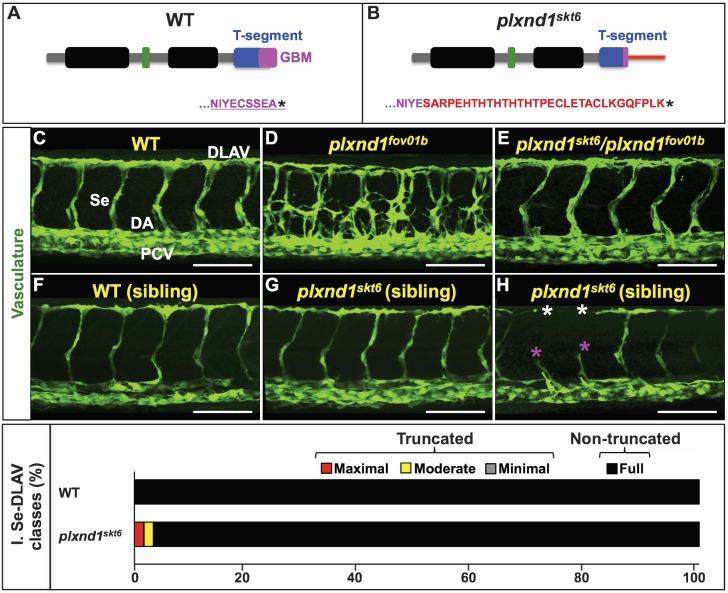
The plxnd1skt6 allele encodes a functional Plxnd1 receptor putatively impaired in GIPC binding, and its homozygosity induces angiogenesis deficits with low frequency.(A, B) Diagrams of the cytosolic tails of the zebrafish Plxnd1 proteins encoded by the WT (A) and plxnd1skt6 mutant (B) alleles including their C-terminal amino acid sequences. Color-coding is used to highlight the following domains and motifs. GAP1 and GAP2 (Guanosine triphosphatase-Activating Protein domains 1 (left) and 2 (right); black), RBD (Rho GTPase-Binding Domain; green), T-segment (C-terminal segment, includes the GBM; blue), and GBM (GIPC-Binding Motif; magenta). In the WT protein diagram (A), the canonical PBM (PDZ-Binding Motif) is underlined. In the mutant protein diagram (B), the thin horizontal red bar denotes the amino acid sequence replacing the PBM. (C–H) Confocal lateral images of the trunk vasculature (green) of 32 hpf embryos (region dorsal to the yolk extension). Anterior, left; dorsal, up. Scale bars (white horizontal lines), 100 μm. Genotypes indicated on top of each image in yellow font. Angiogenesis deficits are indicated with asterisks as follows: white (DLAV gaps), magenta (truncated Se). In the WT image (C), the vessels are designated with the white font as follows: DLAV (Dorsal Longitudinal Anastomotic Vessel), Se (Segmental Vessel), DA (Dorsal Aorta), and PCV (Posterior Cardinal Vein). The homozygous WT and homozygous plxnd1skt6 mutant embryos (F–H) are siblings derived from the incross of plxnd1skt6/+heterozygotes. (I) Bar graph. Percentage of Se-DLAV in 32 hpf embryos of the indicated genotypes belonging to each of the following four phenotypic classes. Truncated: maximal (red; includes missing Se), moderate (yellow), and minimal (gray). Non-truncated: Full (black). There was no statistically significant difference in the distribution of the four phenotypic classes between WT and plxnd1skt6 mutants as assessed by a two-sided Fisher Exact test, p=0.05905. Quantifications. To determine whether plxnd1skt6 complements the plxnd1fov01b null, we analyzed vascular patterning (C–E) and scored Se-DLAV angiogenesis (C, E) in embryos of the following three genotypes: WT (124 Se-DLAV, 11 embryos, an average of 11.27 Se-DLAV/embryo), plxnd1fov01b homozygotes (12 embryos), and plxnd1fov01b/plxnd1fov01b transheterozygotes (162 Se-DLAV, 16 embryos, an average of 10.13 Se-DLAV/embryo). All the WT and transheterozygotes displayed proper vascular patterns indistinguishable from each other and lacked Se-DLAV truncations. All the plxnd1fov01b mutants displayed hyperangiogenic vascular mispatterning. To determine how Plxnd1’s inability to interact with GIPCs impacts angiogenic growth, we scored Se-DLAV angiogenesis (F–I) in sibling embryos of the following two genotypes: Homozygous WT (126 Se-DLAV, 12 embryos, an average of 10.5 Se-DLAV/embryo) and plxnd1skt6 homozygous mutants (124 Se-DLAV, 12 embryos, an average of 10.33 Se-DLAV/embryo). For additional data, graphs and statistical comparisons related to this figure, see Figure 2—figure supplement 1 and Supplementary file 3.